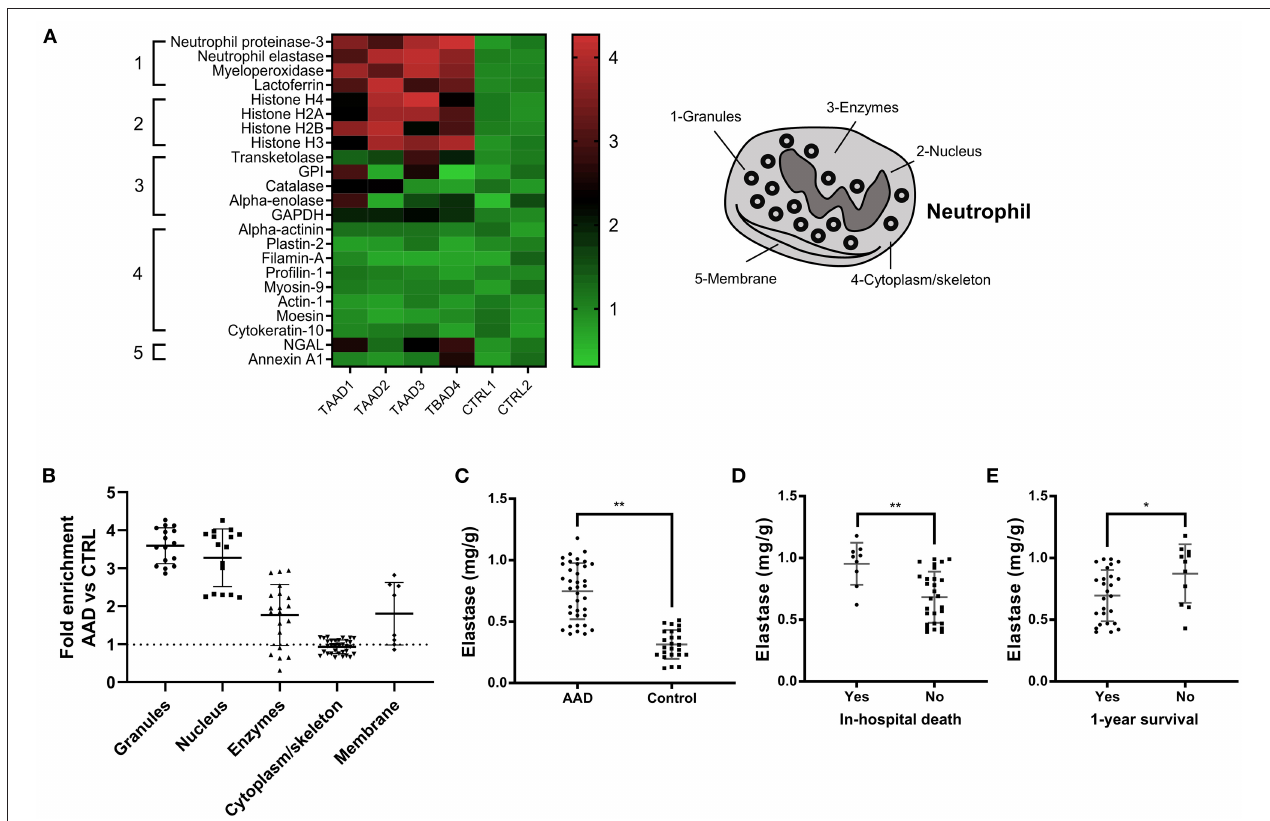
FIGURE 5 | Custom proteomic analysis of aortic tissue lysates from AAD patients. (A) Twenty-three proteins that belonged to five subcellular compartments (nucleus, granules, cytoplasm/cytoskeleton, enzymes, and plasma membrane) were identified to build a custom “NETosis” pathway. Profile plot from the Gene Set Enrichment Analysis (GSEA) showing highly significant enrichment of most proteins in the custom NETosis pathway in the 4 replicates (TAAD1-3, TBAD 4) compared with negative control subjects (CTRL1-2). The false discovery rate–adjusted P value for this analysis, according to GSEA output, was < 0.01. (B) The expression of granules and nuclear NET components was significantly higher, and non-granular enzymes and membrane components were mildly enriched in aortic tissue from AAD patients. (C) Neutrophil elastase was significantly higher in aortic tissue from the AAD group than in aortic tissue from the control group. (D,E) The elastase level in patients with in-hospital death or without 1-year survival was significantly higher than that in patients without in-hospital death or with 1-year survival. * P < 0.05, ** P < 0.01.